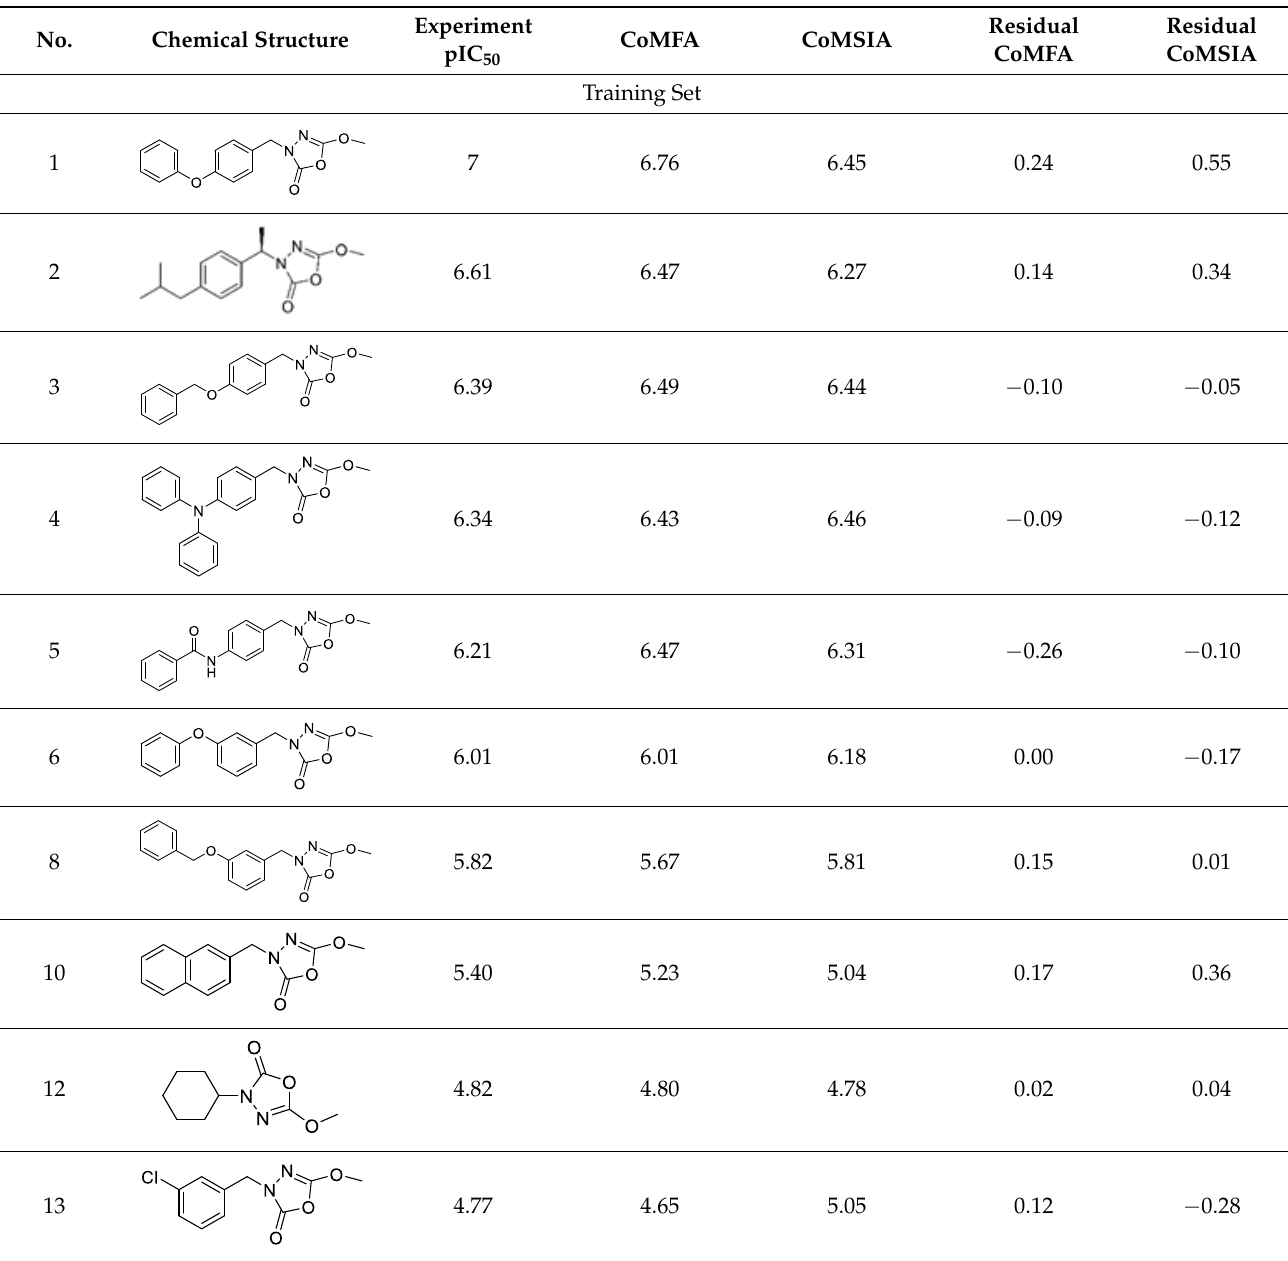
Table 1. Modeling set (the training set and the test set) used in the 3D-QSAR study. No. Chemical Structure Experiment CoMFA CoMSIA Residual CoMFA Residual CoMSIA pIC 50